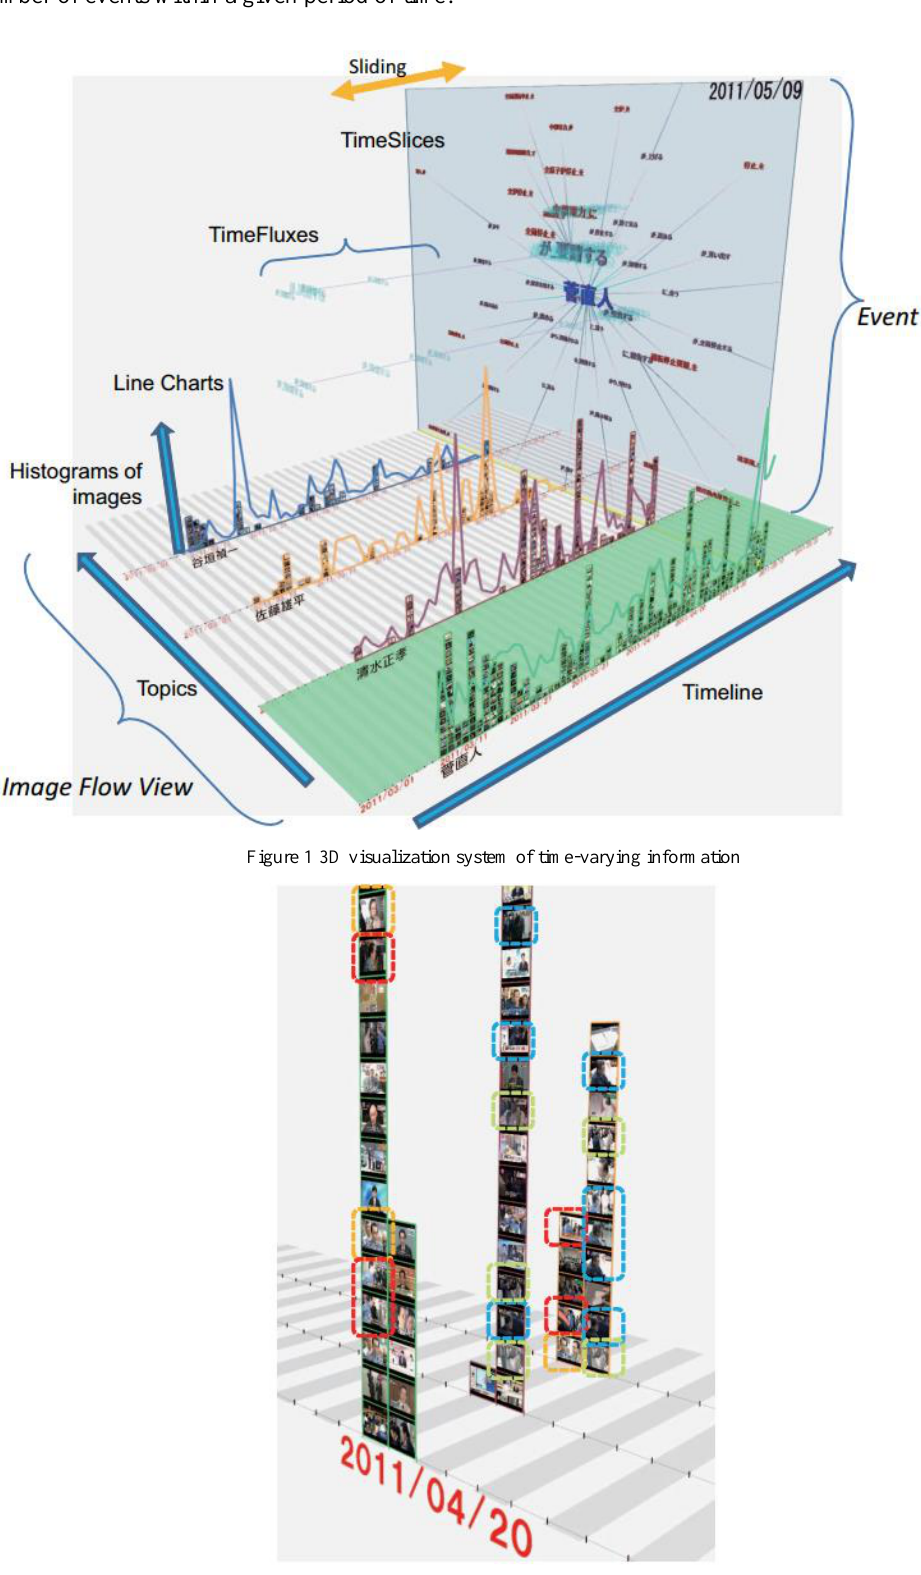
Figure 2 stacked images clustered on